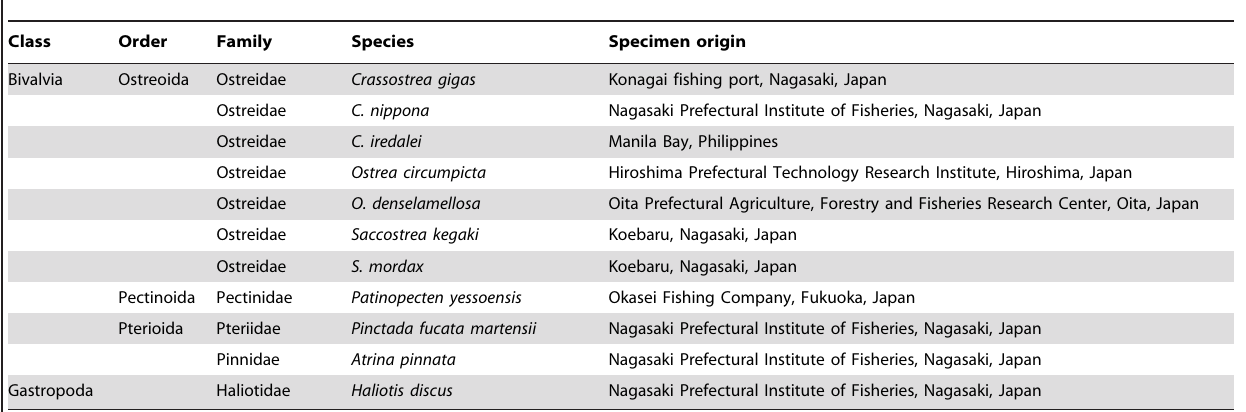
Table 1. Taxonomy of the 11 species of mollusks used as